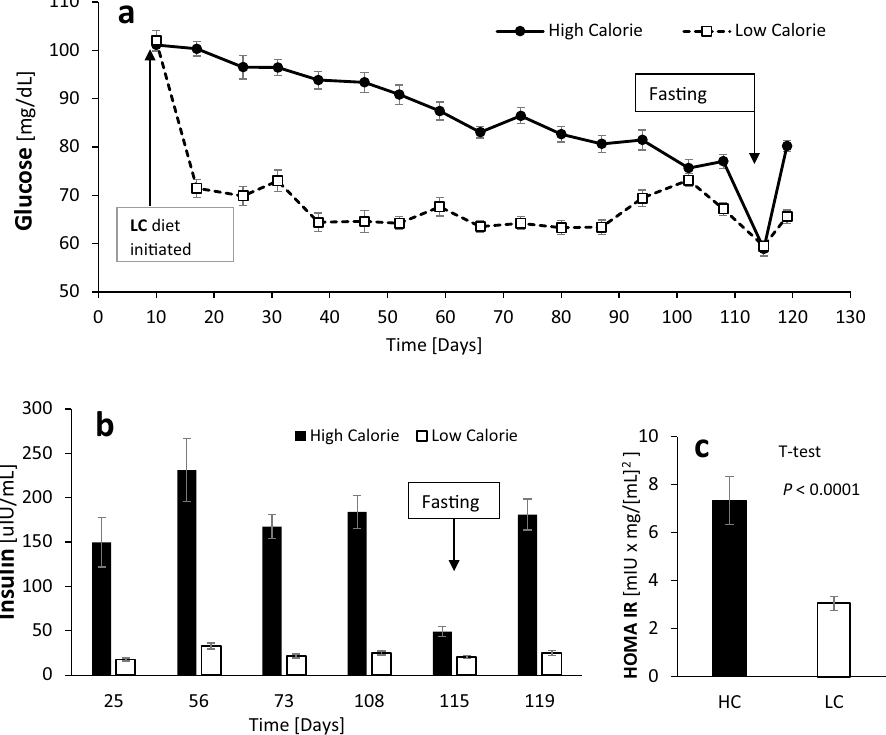
Figure 1. Glucose and Insulin Response to the dietary treatments. ( a ) Glucose response. Repeated measures ANOVA shows an effect of: treatment ( P < 0.0001), time ( P < 0.0001), treatment-time interaction ( P < 0.0001) and individual animal ( P < 0.0011). SEM = 0.638. The fasting glucose, at day 115 from treatment, was not included in the ANOVA. Both treatment groups were given a 10-day acclimatization period in the experimental pen with diets with similar metabolizable energy of ~ 4.86 MCal. ( b ) Insulin response. The analysis shows an effect of treatment ( P < 0.0001), time ( P < 0.0001), individual animal ( P < 0.0101) but no treatment by time interaction. SEM = 8.29. Fasting insulin concentrations were higher in the HC group ( P < 0.0002), but excluded from the overall ANOVA with repeated measures analysis. ( c ) Insulin resistance measured by HOMA-IR.